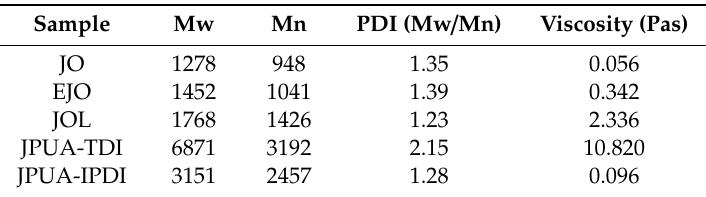
Table 5. Molar mass of jatropha-oil based